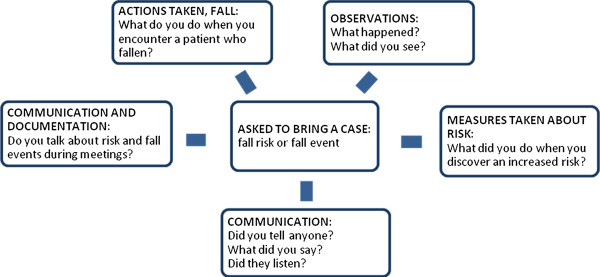
Focus group guide.